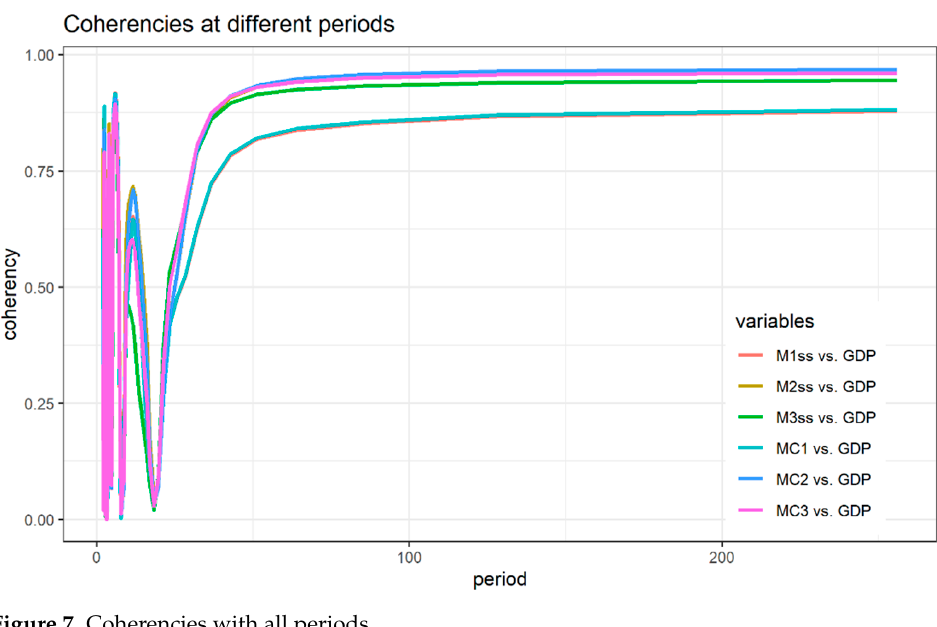
Figure 7. Coherencies with all periods.